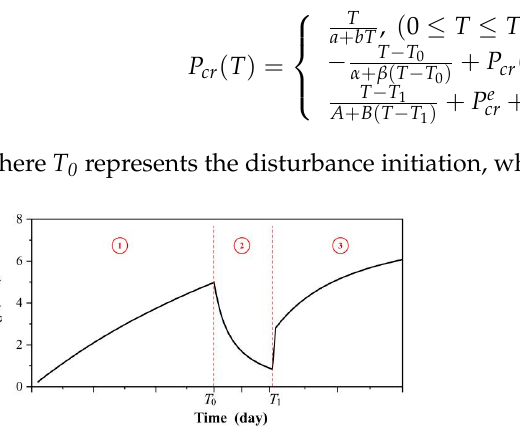
Figure 11. Relationship between 1/ A , 1/ B , e cr P and concentration.